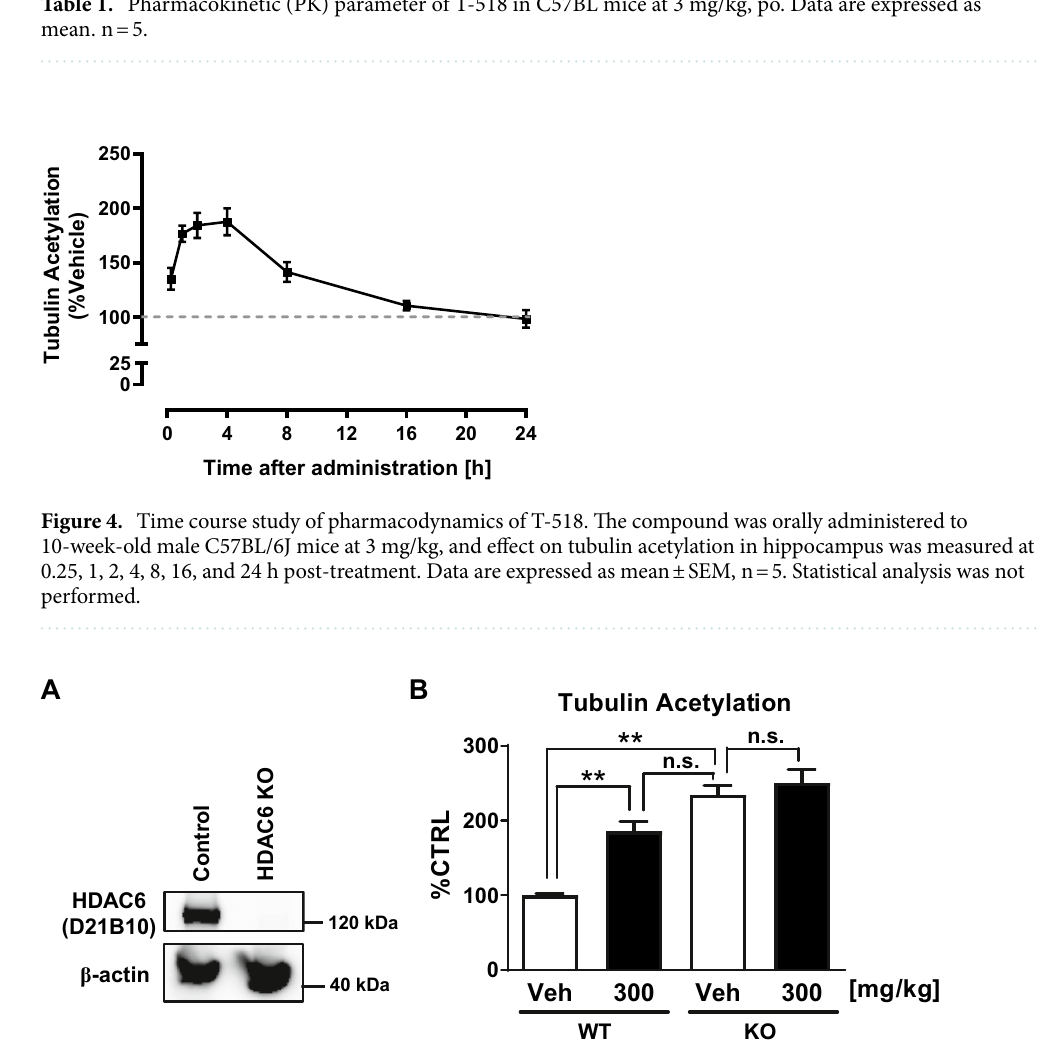
Figure 5. HDAC6 dependency of in vivo pharmacodynamics effect of T-518. Absence of HDAC6 expression in the cerebral cortex of HDAC6 KO mice was confirmed by Western blotting ( A ). T-518 was administered to 27-week-old male WT mice or HDAC6 KO mice at 300 mg/kg, and tubulin acetylation was assessed ( B ). Full-length gel of ( A ) is presented in Figure S6. Data was expressed as mean ± SEM and analyzed statistically as a follow: Tukey test (** p < 0.01), n = 5. n.s. not